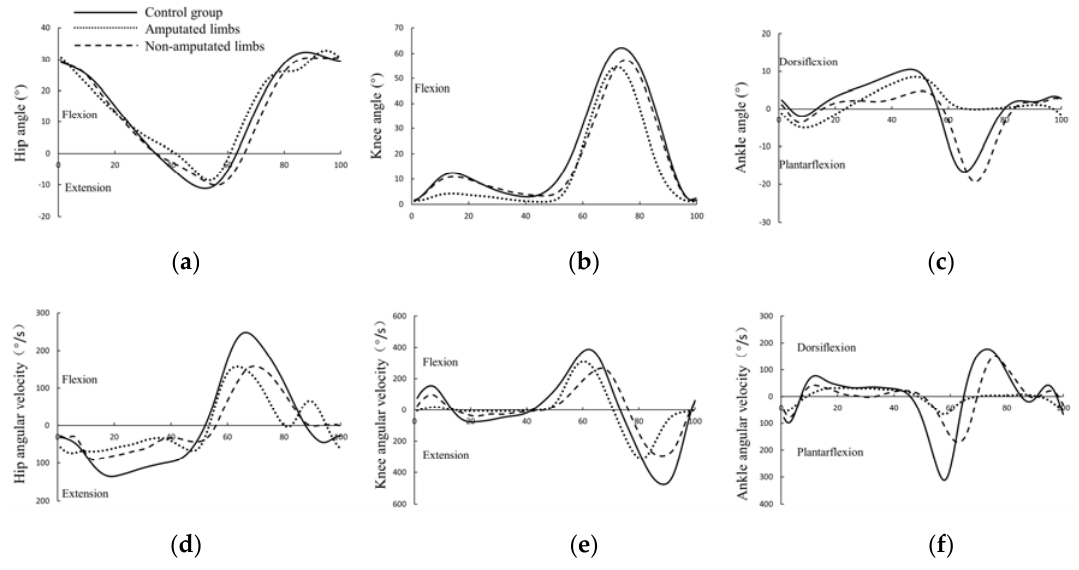
Figure 4. Comparison of the ensemble mean curves of the angular velocities in the gait cycle: ( a ) hip joint angle, ( b ) knee joint angle, ( c ) ankle joint angle, ( d ) hip joint angular velocity, ( e ) knee joint angular velocity, ( f ) ankle joint angular velocity.